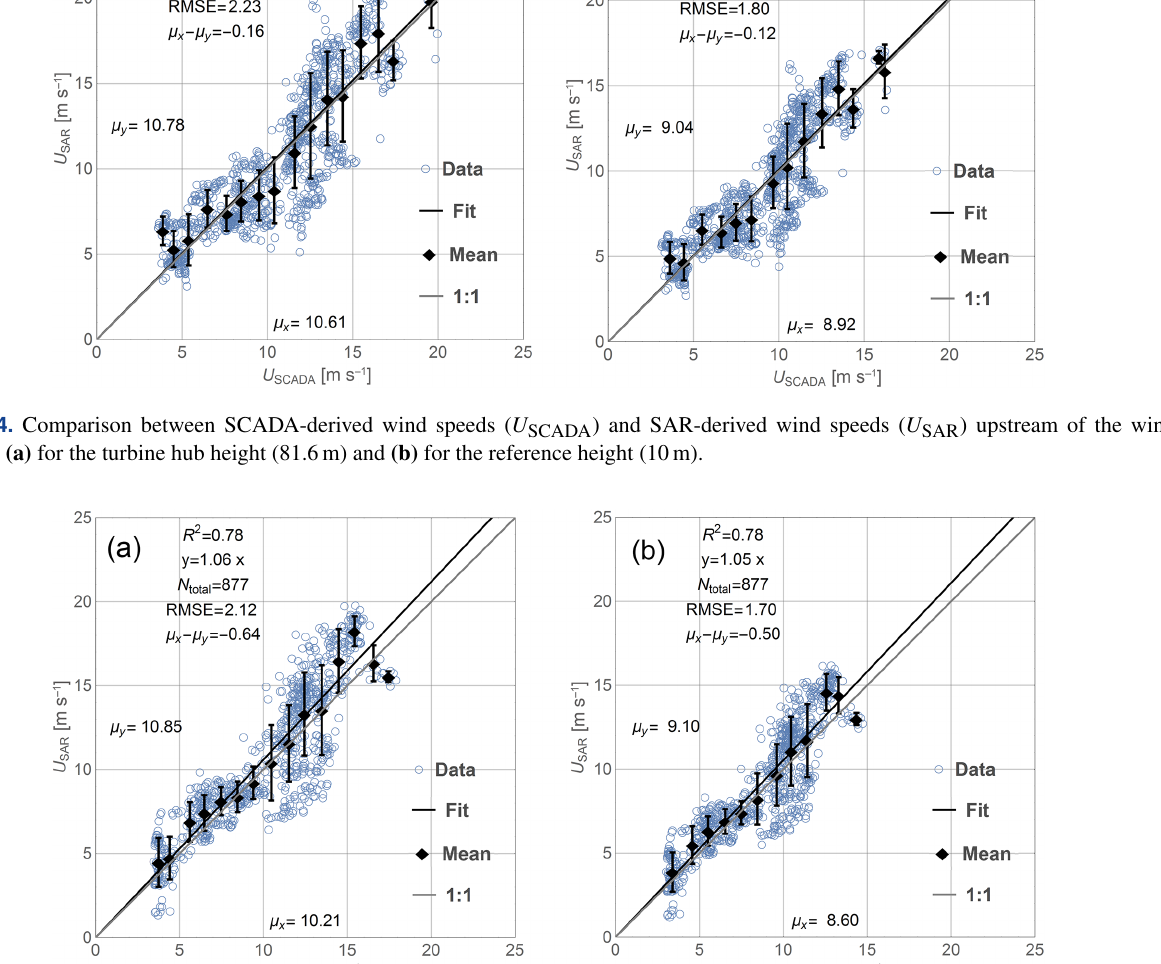
monotonically increasing mean wind speed from south